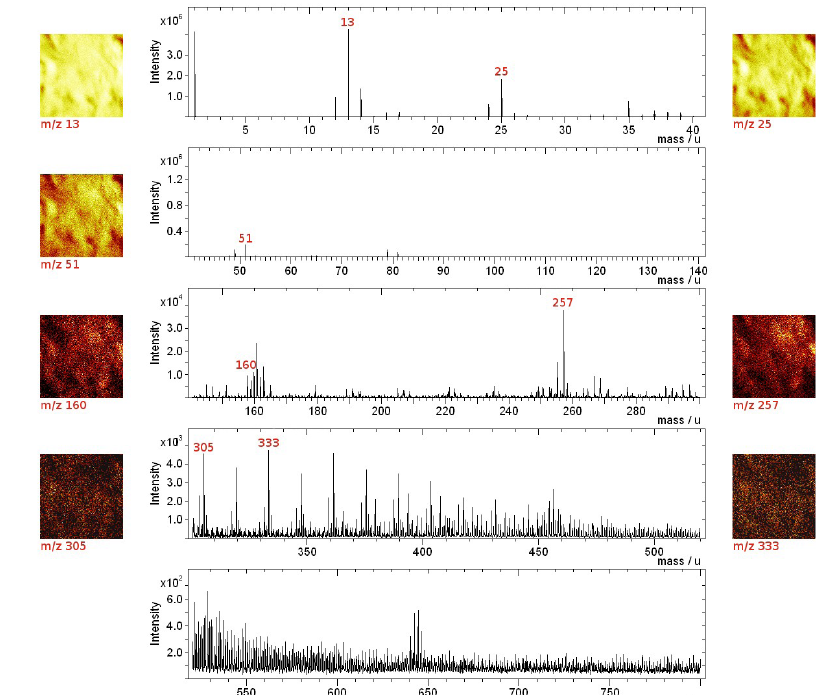
Figure 7. SIMS spectra of hexadecanethiol SAM onto the Ag functionalisated with L-Tryptophan in negative